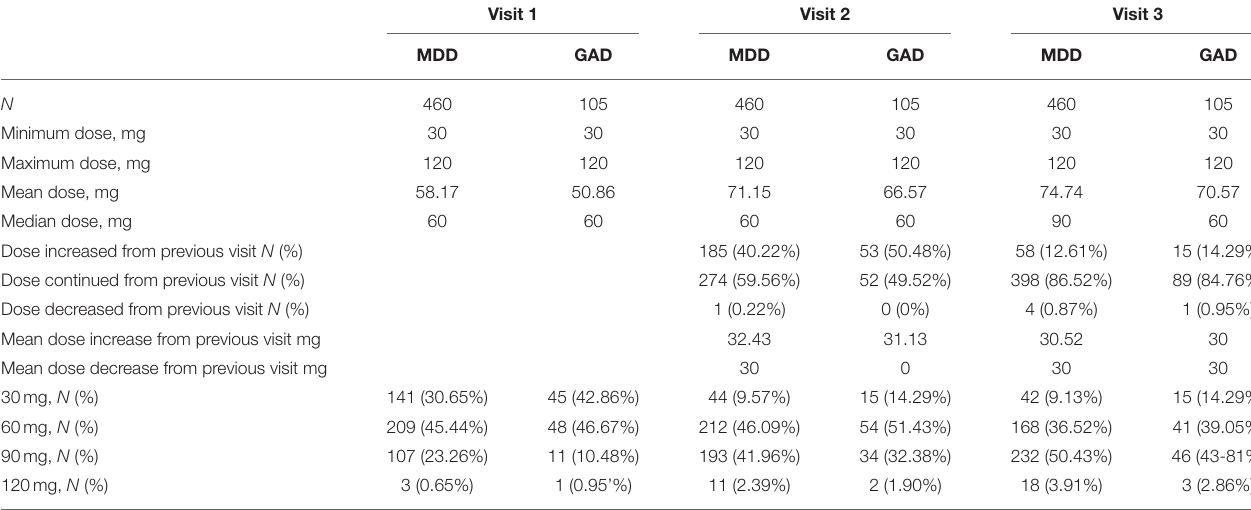
TABLE 2 | Doses of duloxetine and dose adjustments during the 8-week study period in MDD and GAD